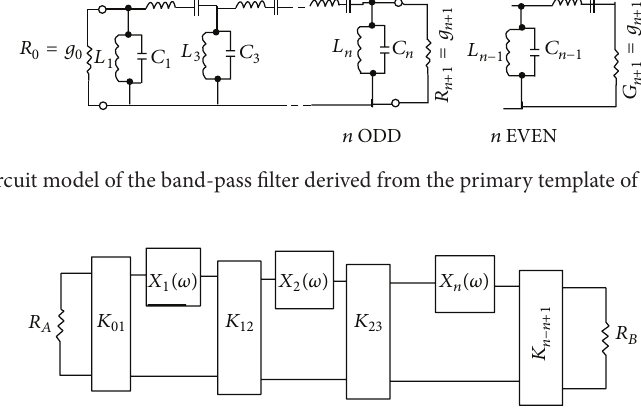
Figure 3: Circuit model of the band-pass filter using K transformers and serial reactance.